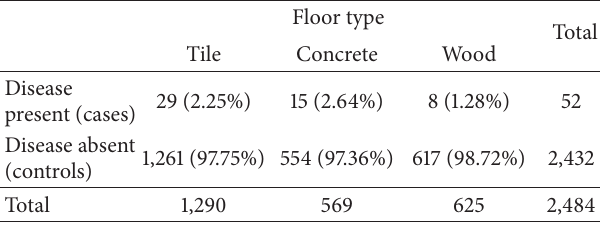
Table5:Numberofpuppiesperlitterinnormalandaffectedgroups. Table 6: Number of litters on different floor types.